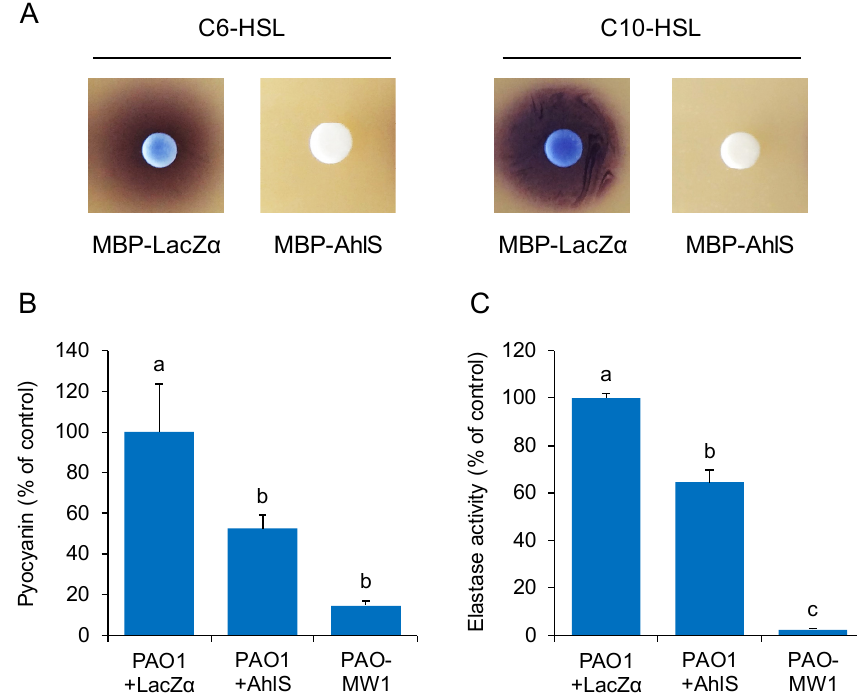
Figure 4. ( A ) AHL-degrading activities of MBP-LacZ α and MBP-AhlS. Purified proteins were mixed with an equal volume of 20 µ M C6-HSL or C10-HSL solutions and incubated at 37 ◦ C for 30 min. The residual AHL was detected using C. violaceum CV026 or VIR07, respectively. Pyocyanin production ( B ) and elastase activity ( C ) in culture supernatants of Pseudomonas aeruginosa PAO1 treated with MBP-LacZ α or MBP-AhlS. PAO-MW1 was used as the quorum-sensing-negative control. The average value of PAO1-LacZ α was defined as 100%. The data were reproduced at least three times and the error bars indicate standard deviations. Di ff erent lowercase letters indicate significant di ff erences, as determined by the Tukey’s HSD test ( p < 0.05).